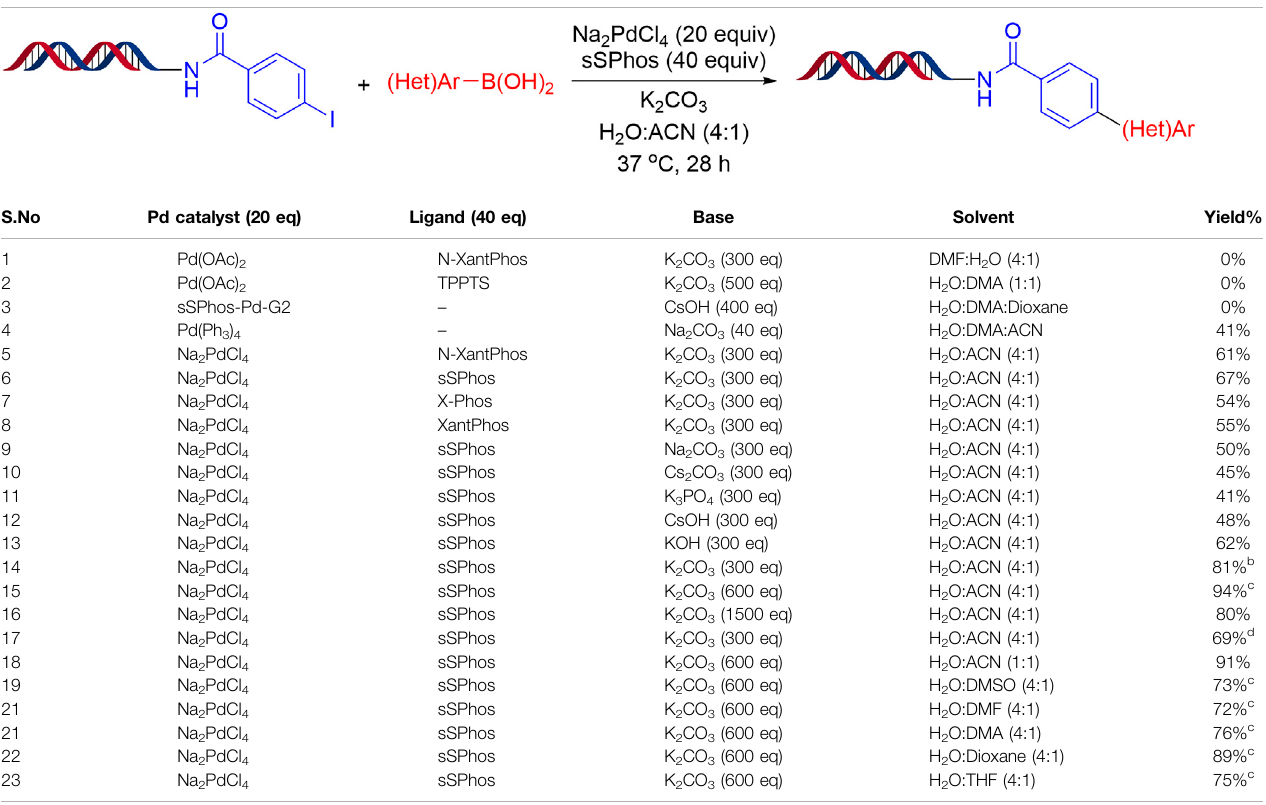
TABLE 1 | Optimization of Suzuki-Miyaura Cross-Coupling Reaction a .